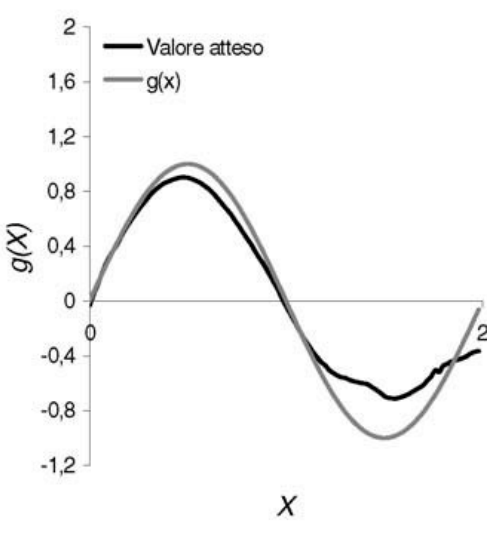
Figura 5 – Modello II: valore atteso del supersmoother.